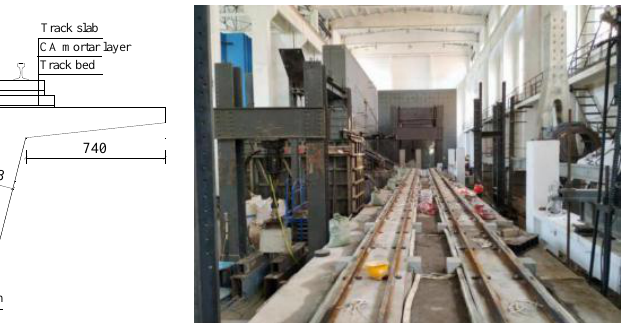
( b ) Picture of the specimen